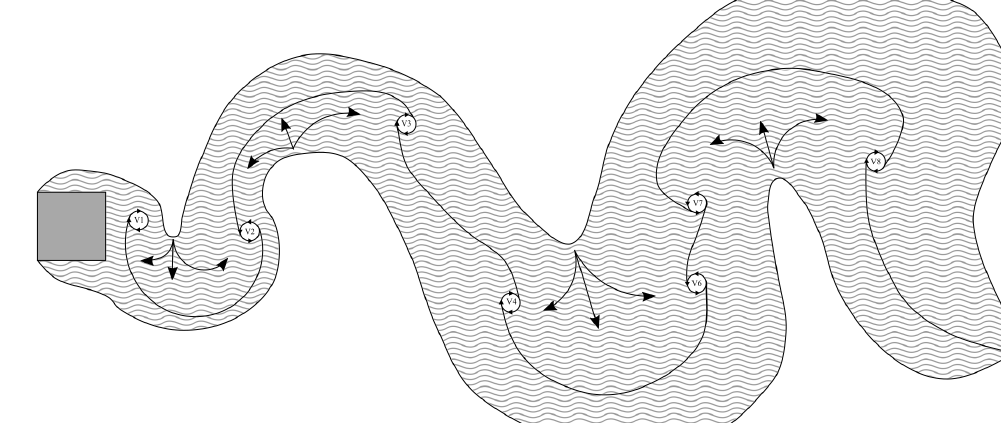
Figure 17. Instantaneous non-dimensional vorticity Z component ω ∗ for 0 < a x and a x < 0 recorded at V ref = 6 ms − 1 . The top and bottom rows represent flow approximately 180 ◦ out of phase.